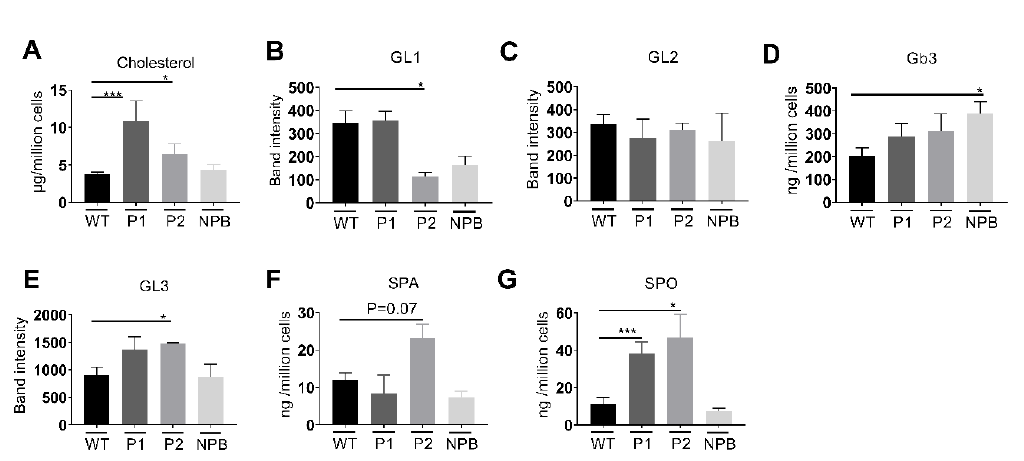
Figure 2. Lipid analysis from total cell lysates. Cholesterol ( A ), sphinganine ( F : SPA) and sphingosine ( G : SPO) analysis was performed by HPLC and glycolipid analysis by TLC. Cholesterol and sphingolipid concentrations are given as ng cholesterol per 1 × 10 6 cells. Four glycolipids were present in significant concentrations, Globotriaosylceramide ( D : Gb3), glycolipid 1, 2, 3 ( B : GL1, C : GL2 and E : GL3). Each bar equates to at least three repetitions, with the wild type (WT) corresponding to the average of three repetitions of three WT fibroblasts from independent healthy donors. P1: NPC-I1061T / P887L, P2: NPC-D874V / D948Y. SEM, Student’s t -test * p ≤ 0.05, *** p ≤ 0.001. n = 3–11.